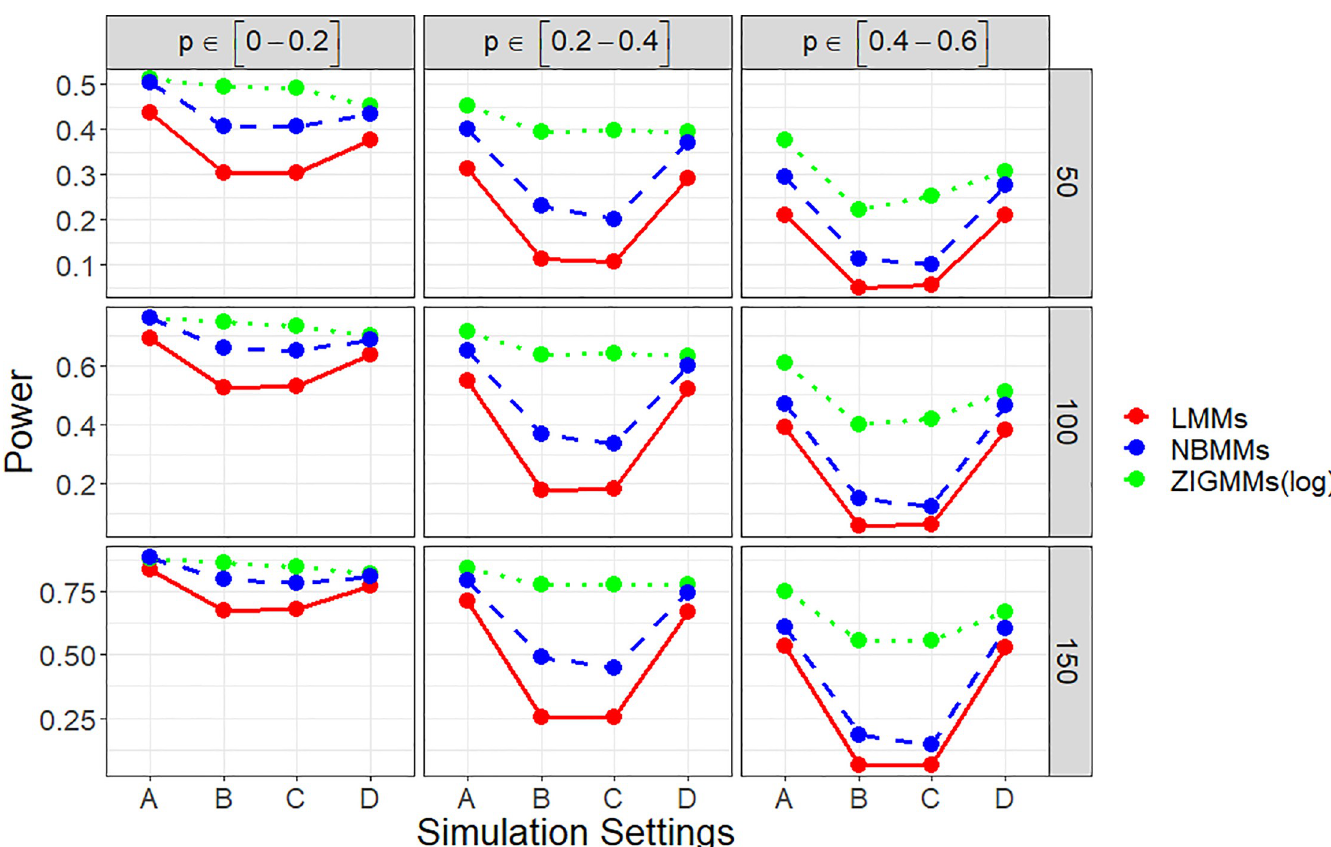
Fig 1. Empirical powers in four simulation settings under low effect